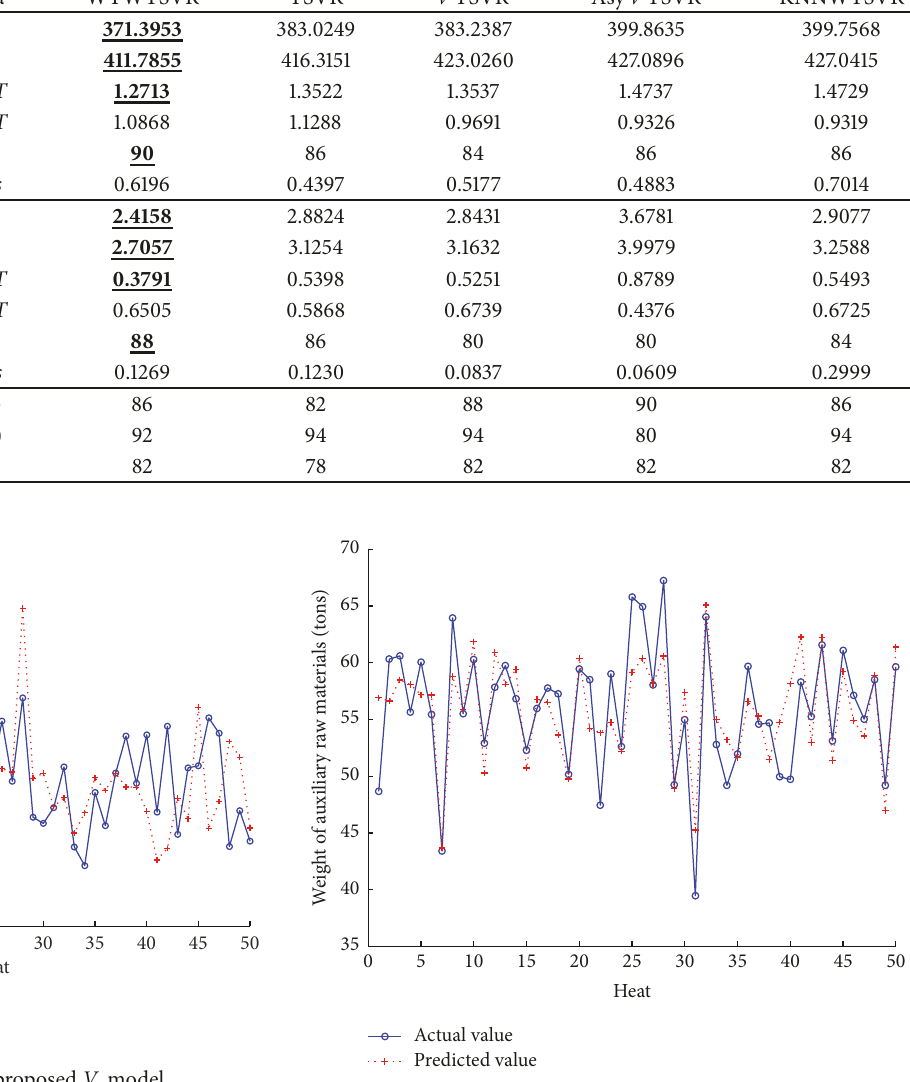
Figure 8: Performance of proposed W